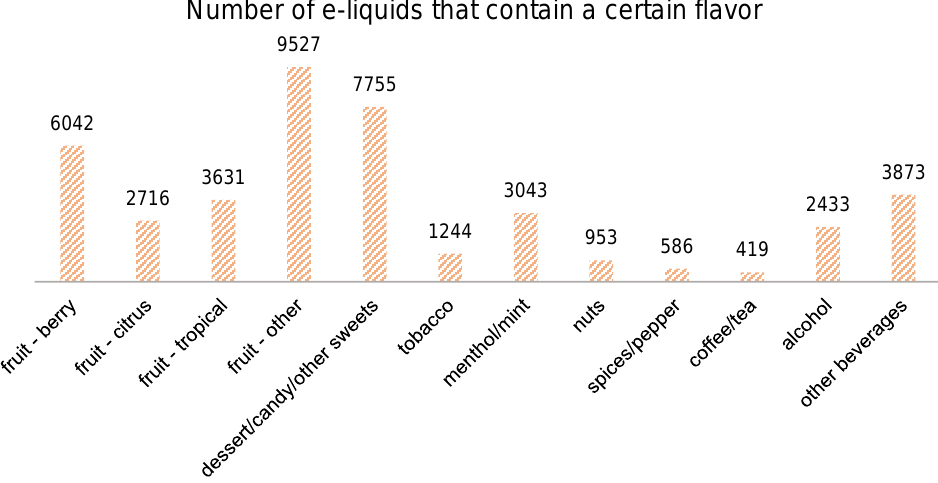
Figure 1. Frequencies of E-liquids Containing a Certain Flavor (Product Total N = 14,477).